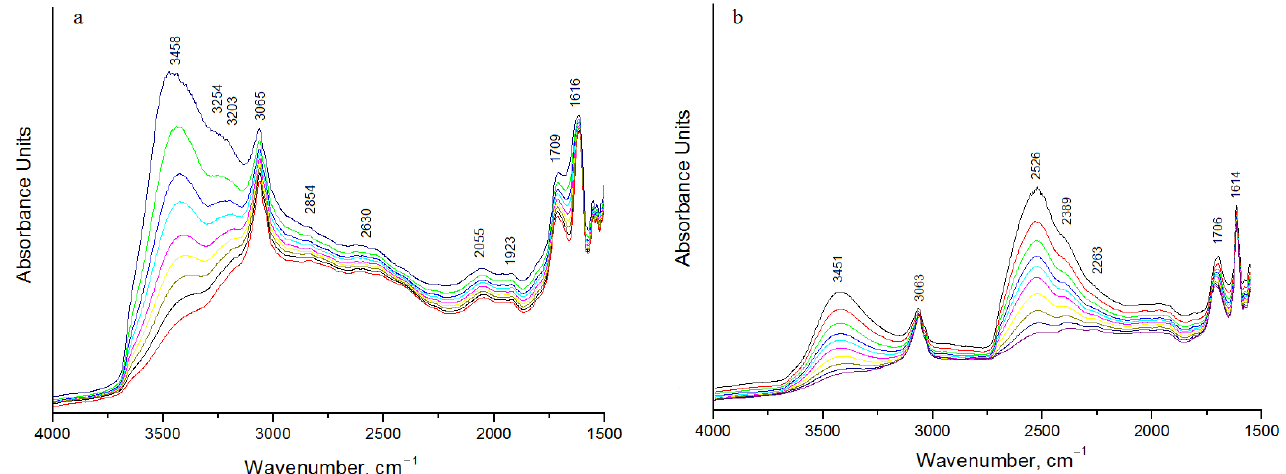
Figure 9. The contours of the bands ν (OH) of physically adsorbed water and proton hydrates ( a ) and the contours of the bands (OD) of physically adsorbed heavy water and deuterohydrates D + ( b ), recorded during the holding of the initial extremely hydrated SPPQ 5.5% film under vacuum (<1hPa) at room temperature.